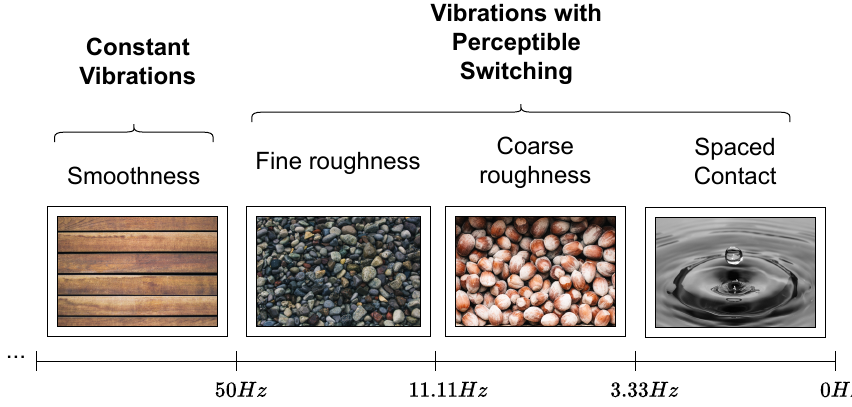
Figure 6. Association among tactile sensations, vibrations and frequency ranges.